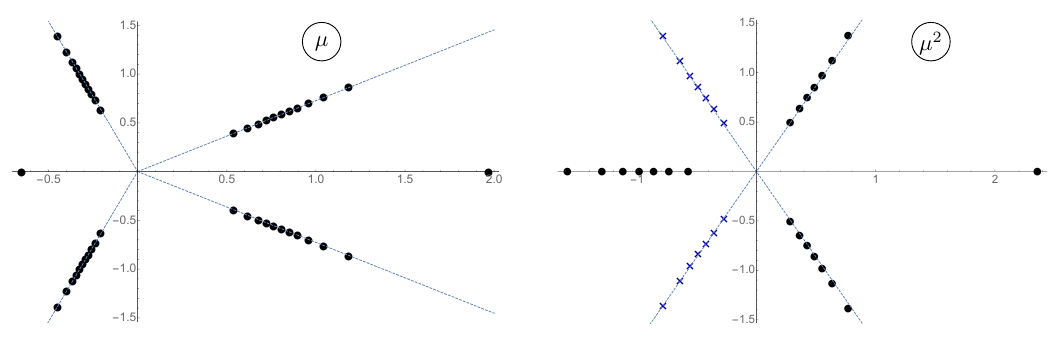
( (cid:22) ) are depicted in the complex plane for n = 5, + (circles) and Z (vac) (crosses) as + (cid:0)